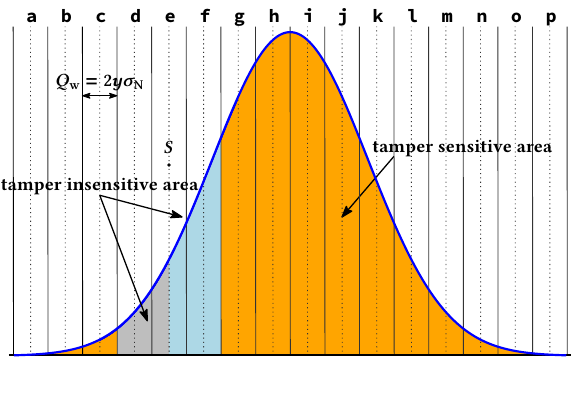
of Profile node